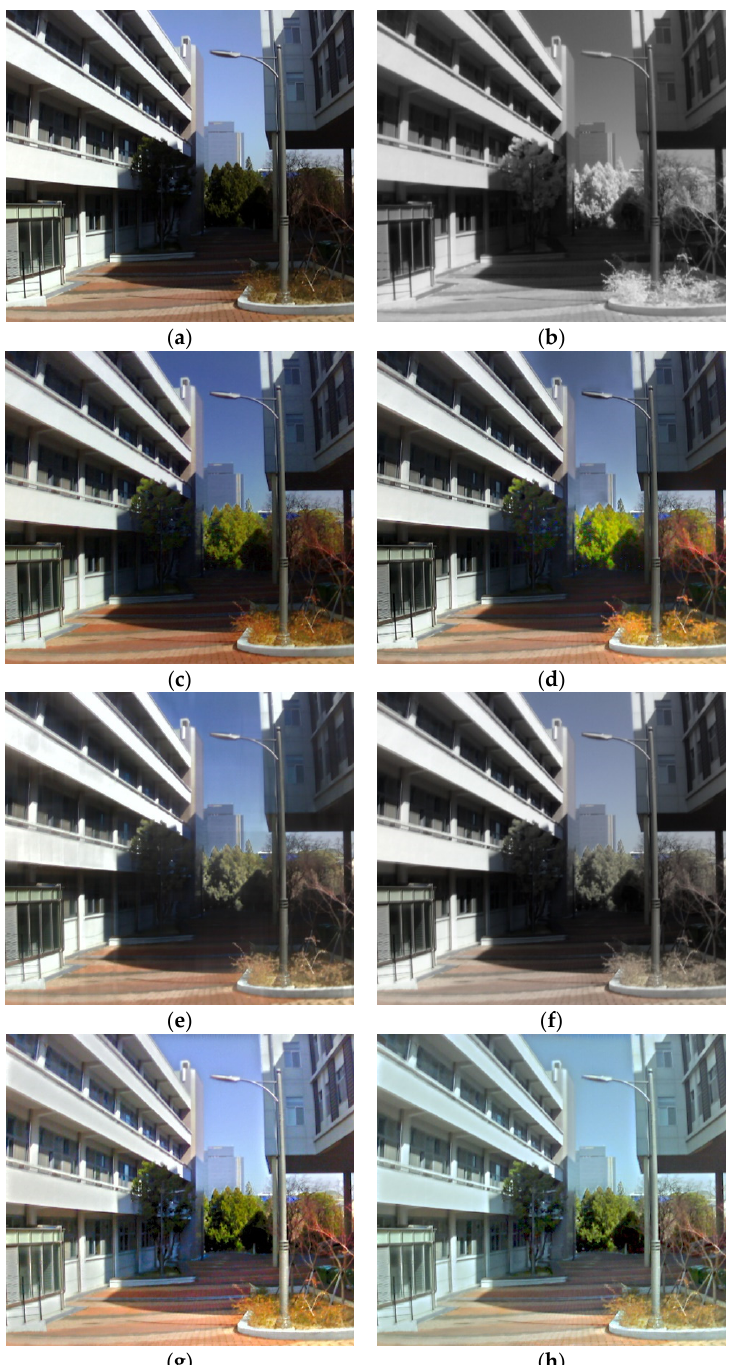
Figure 14. Input pair images and result images: ( a ) Visible image, ( b ) IR image, ( c ) Laplacian pyramid entropy fusion, ( d ) Laplacian pyramid PCA fusion, ( e ) Low rank fusion, ( f ) dense fusion, ( g ) Proposed method (Luminance channel fusion), ( h ) Proposed method (XYZ channel fusion).